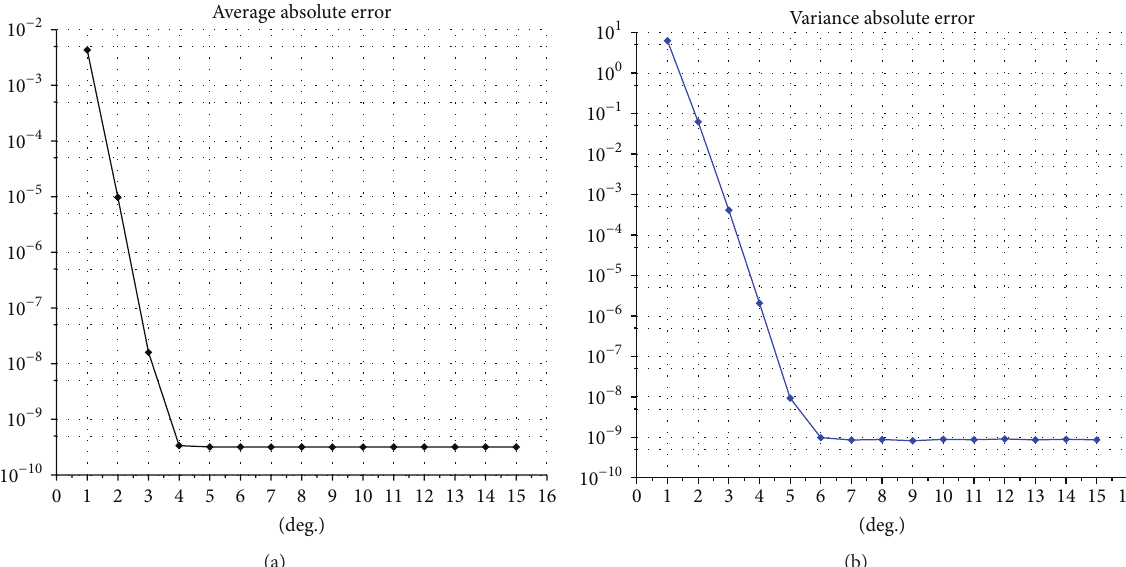
Figure 5: Semilogy scale plot for the absolute error of the mean (a) and variance (b) computed via PCE of GBM at time 𝑇 = 1 (whose parameters are 𝑟 = 3 %, 𝜎 = 15 %, and starting value 𝑆 0 = 100 ) with higher precision at computing {𝑆 𝑇,𝑗 } 𝑁 𝑗=1 .